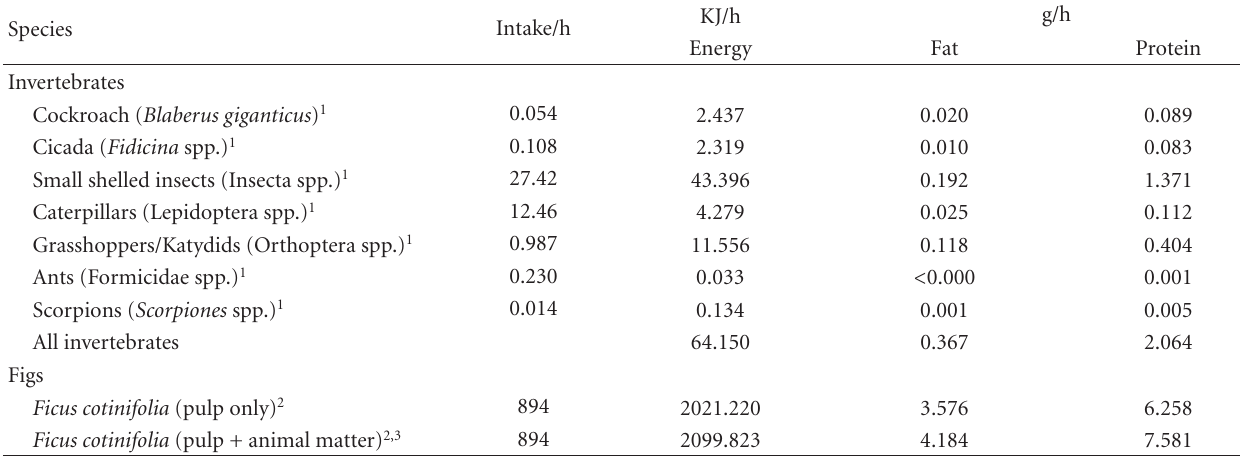
Table 3: Energy, fat, and protein intake rates for Ficus cotinifolia and common invertebrate prey of capuchins in Sector Santa Rosa, ACG, Costa